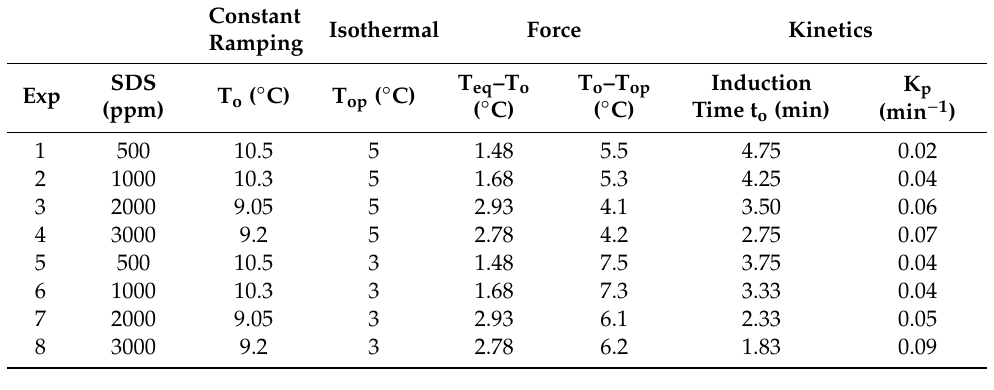
Table 7. 𝑇 (cid:2868) (cid:3398) 𝑇 (cid:3042)(cid:3043) and 𝑇 (cid:3032)(cid:3044) (cid:3398) 𝑇 (cid:2868) calculation based on isothermal and constant ramping experiments at Table 7. T 0 − T op and T eq − T 0 calculation based on isothermal and constant ramping experiments at constant pressure 90 bar. constant pressure 90 bar.